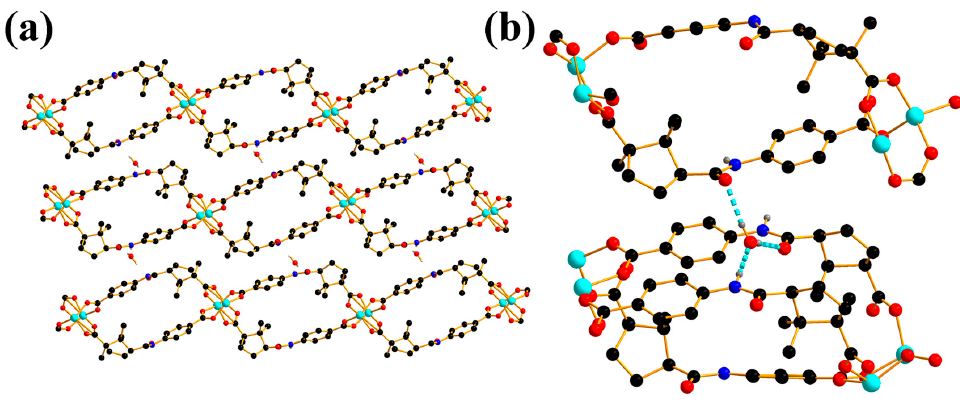
Figure 3. ( a ) The 3D framework of JUC-112; ( b ) The hydrogen bonds between the layers.